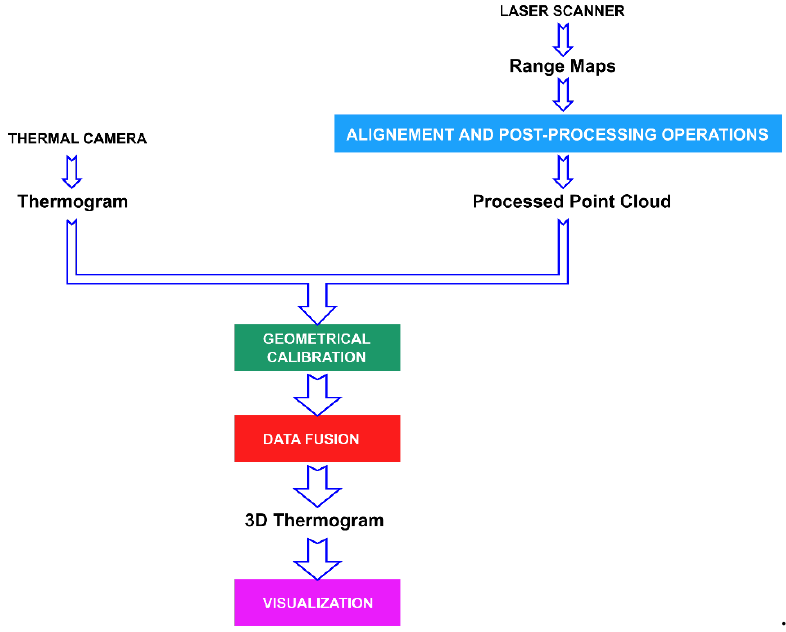
Figure 2. High-level workflow of the integration process.